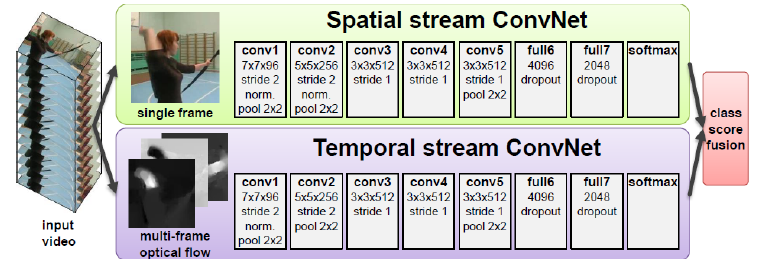
Figure 9. Two-stream Convolutional Neural Network (CNN) architecture (Source Figure 9. Two ‐ stream Convolutional Neural Network (CNN) architecture (Source [148]).